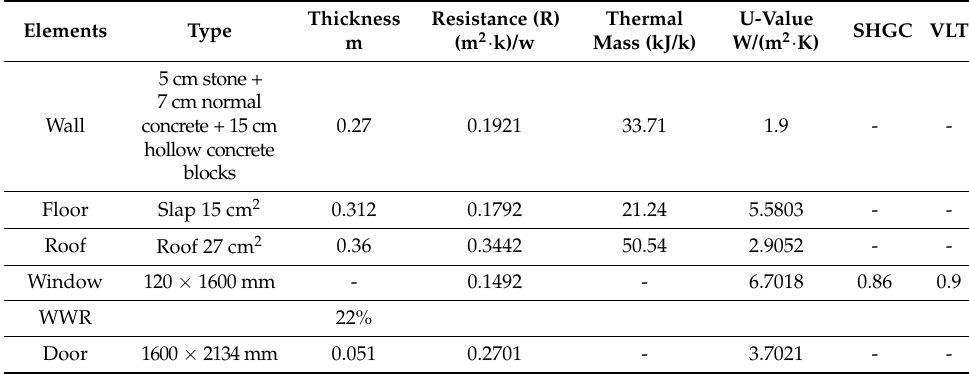
Table 5. Envelope components’ analytical properties (Case 2).